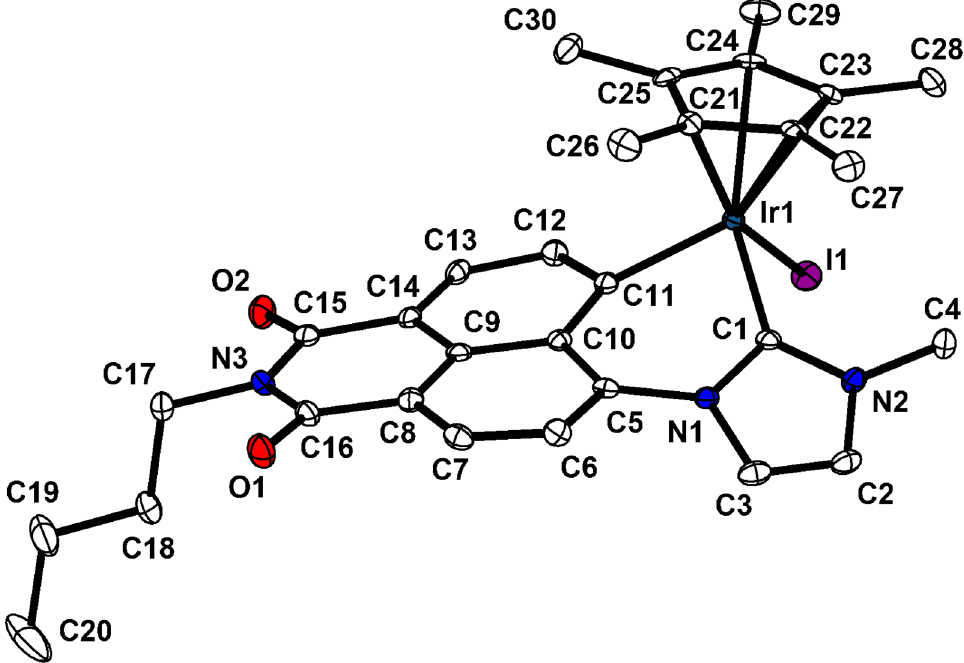
Figure 6. Molecular structure of ( S )- 4 with thermal ellipsoids drawn at the 30% probability level,